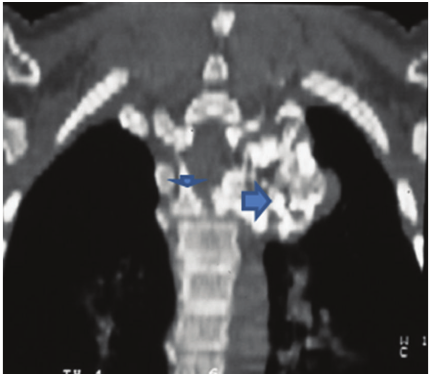
Figure 4: Coronal reformatted CT scan image showed a huge intraspinal mass with heterogeneous intensity. The ossified matrix is surrounded by cartilage tissue. The osseous tumour originating from the left T3–5 facet joint (arrows-arrow head is the pedicle and long arrow is the